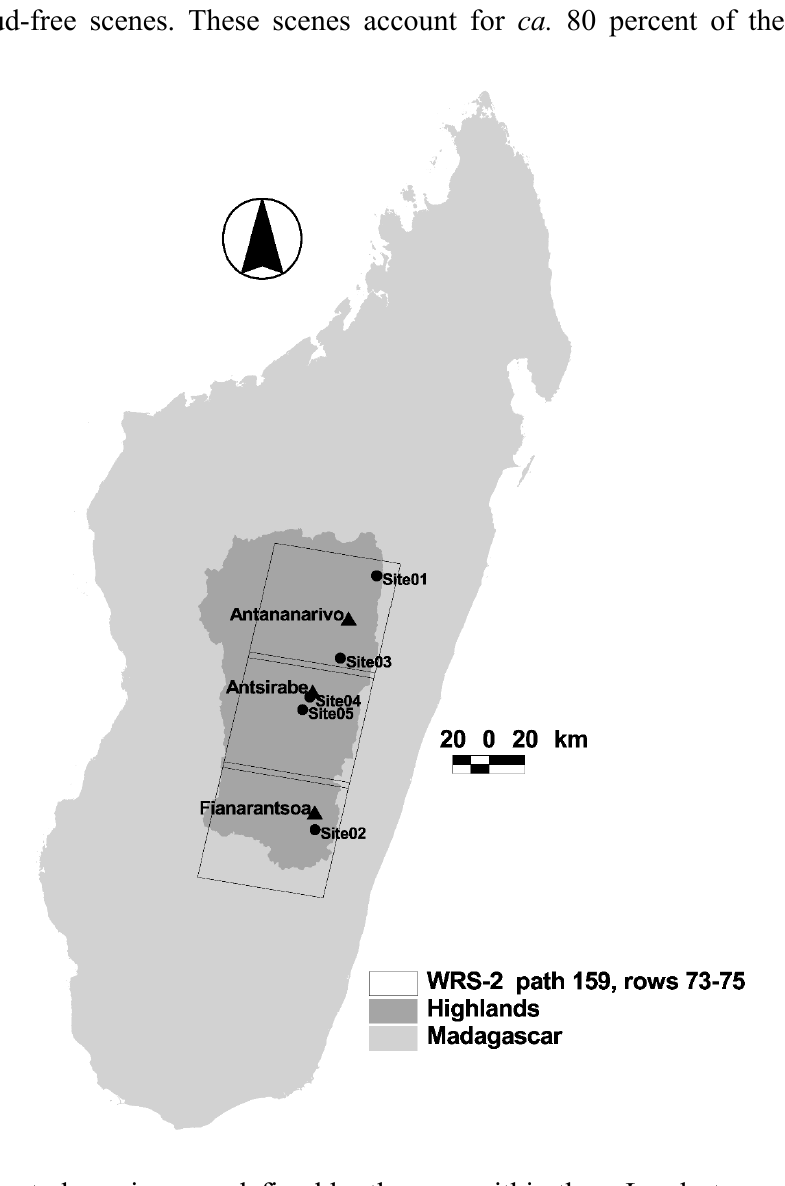
Figure 1. The study region was defined by the area within three Landsat scenes (path 159, rows 73 to 75 of the World Reference System-2 (WRS-2)), comprising ca. 80 percent of Madagascar’s Highlands. Also shown are the locations of three main cities and five field sites visited between 2003 and 2006 whose land-cover dynamics are explained in more detail in the